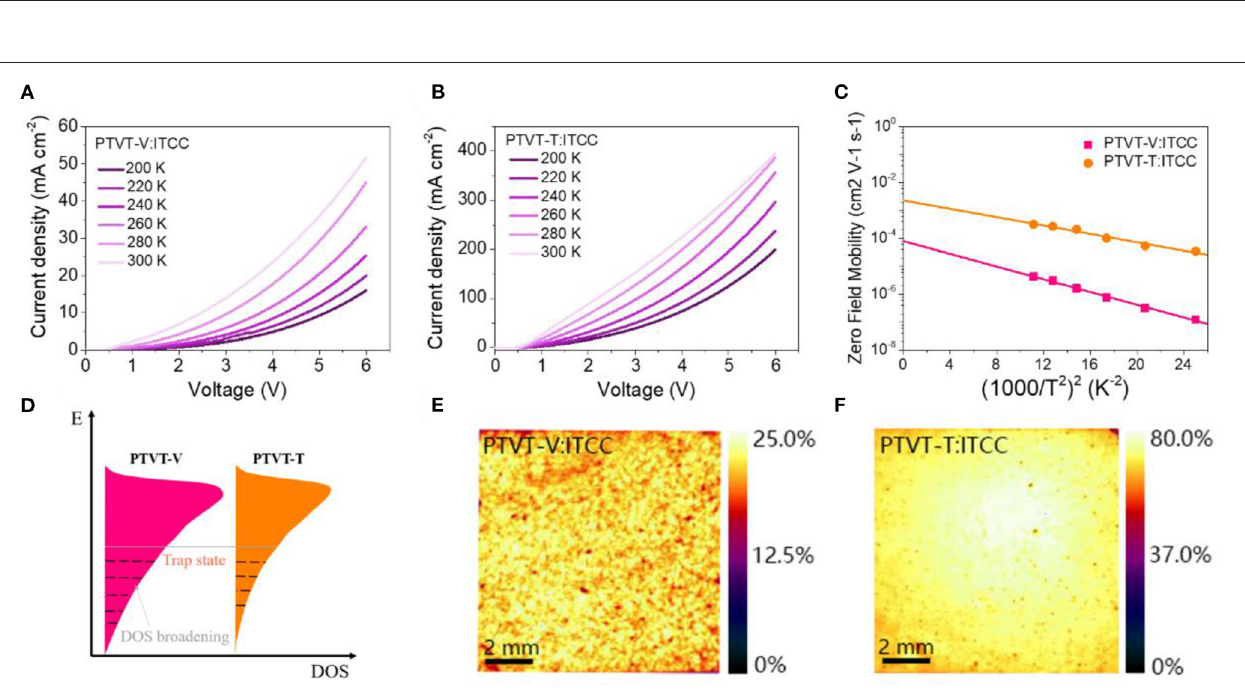
FIGURE 5 | SCLC plots under different temperatures for the devices based on (A) PTVT-V:ITCC and (B) PTVT-T:ITCC. (C) The plots of hole mobilities of the devices as a function of 1/T 2 using SCLC derived data. (D) The diagram of the density of the state (DOS) of HOMO levels of PTVT-V and PTVT-T. The EQE mapping of the blend devices of (E) PTVT-V:ITCC and (F) PTVT-T:ITCC.